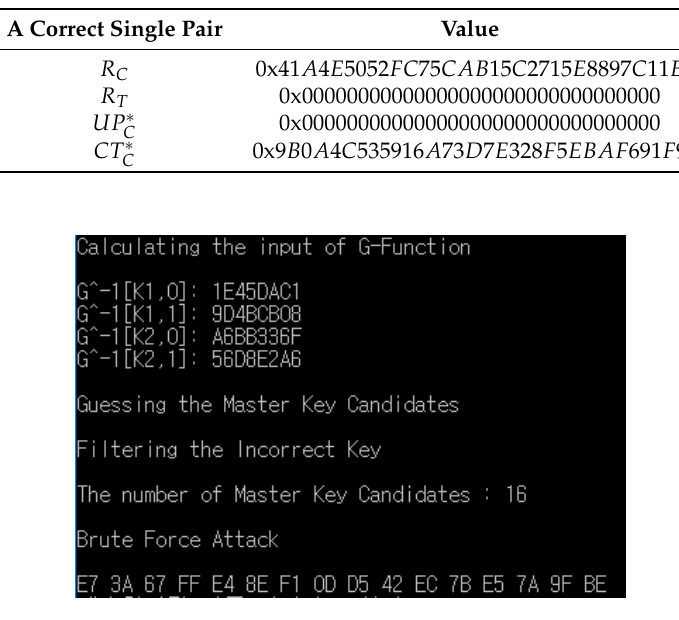
Table 2. A correct single pair.